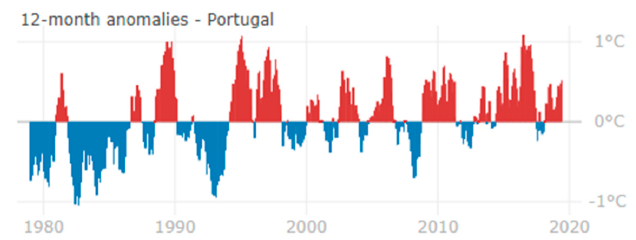
Figure 1. Portugal surface air temperature anomalies relative to the 1981–2010 average, from January 1979 to February 2020. The graph shows the running 12-month average anomalies (red = high temperature anomaly; blue = low temperature anomaly).